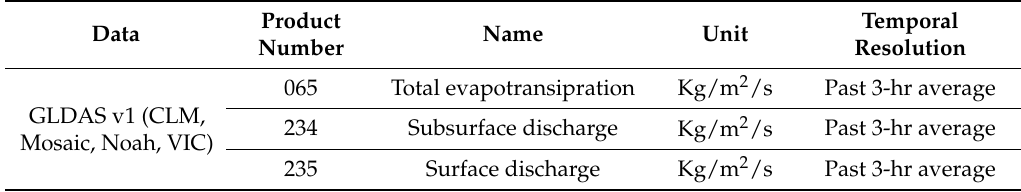
Table 3. The Global Land Data Assimilation System (GLDAS) v1 data description used in this